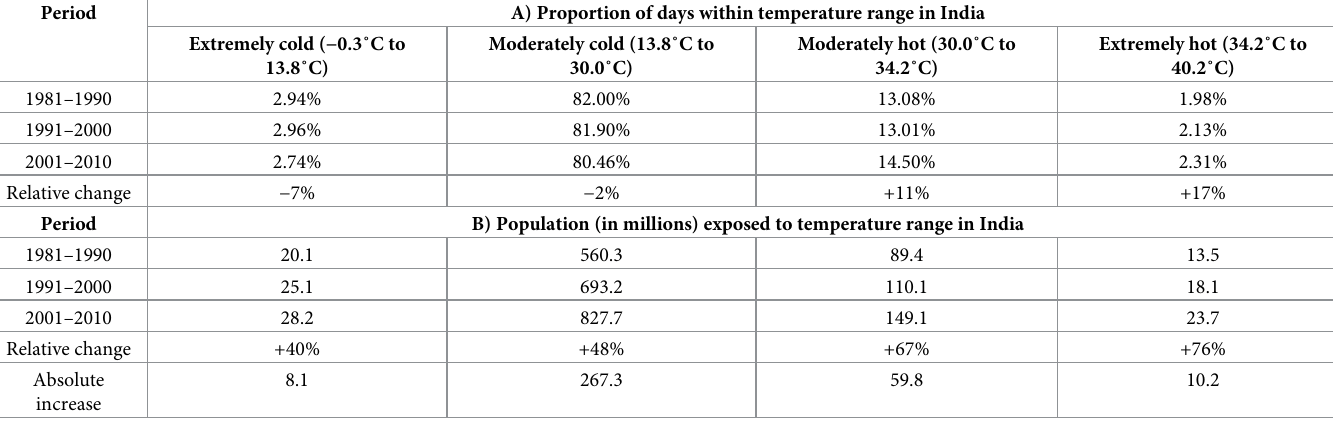
Table 3. Proportion of days within and population exposed to temperature ranges in